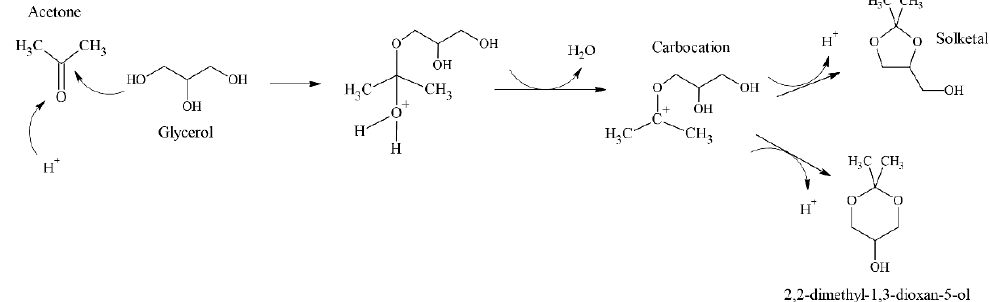
Scheme 1. Ketalization reaction between glycerol and